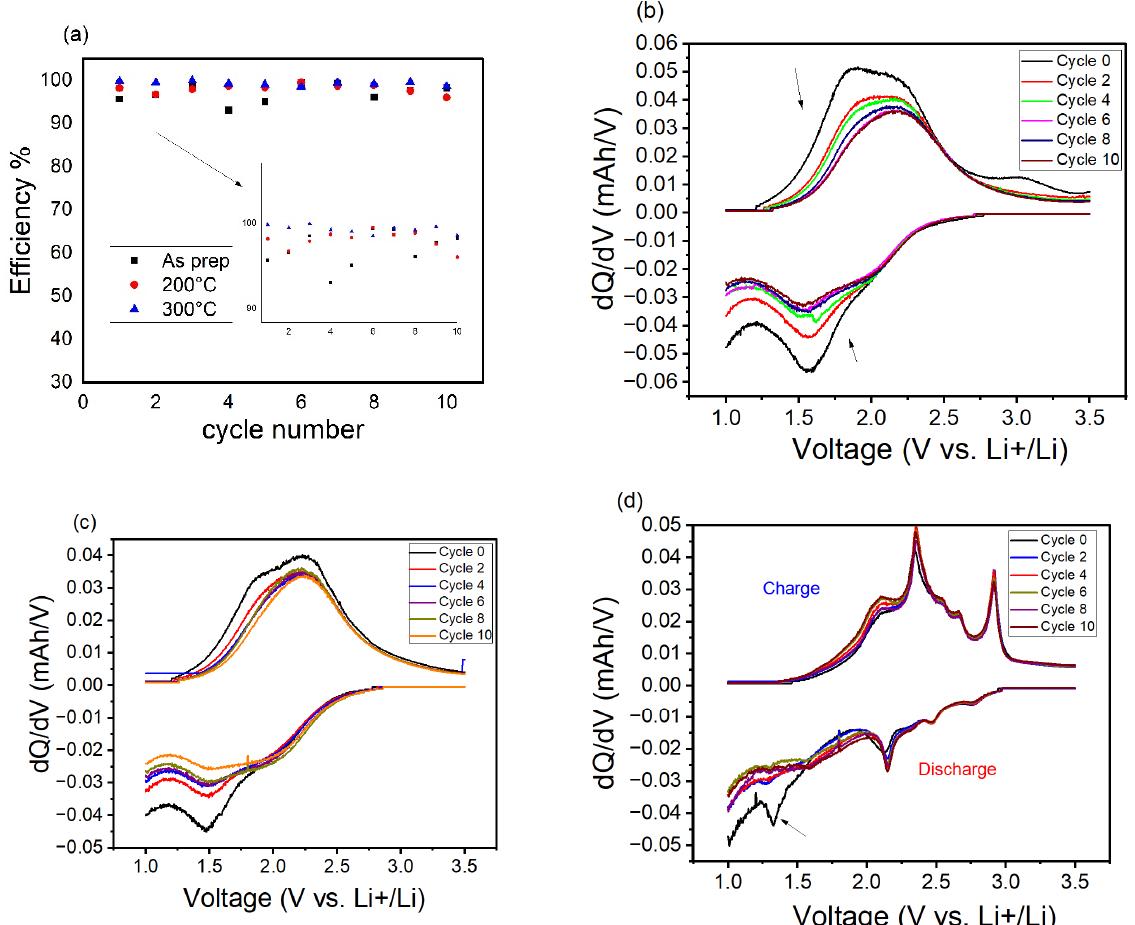
Figure 9. Coulombic efficiency ( a ), Differential capacity graphs of the 3 cells after 10 cycles: ( b ) as- prepared, ( c ) heat-treated 200 °C, ( d ) heat-treated 300 °C. In terms of coulombic efficiency (Figure 9a), the heat-treated layer at 300 ◦ C showed